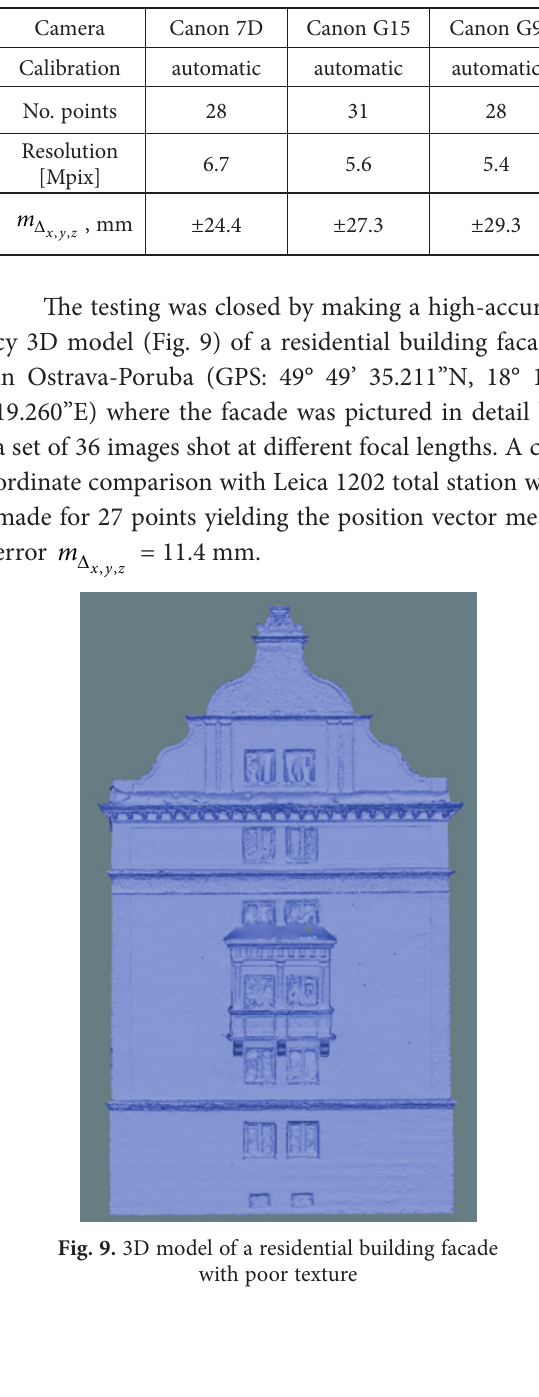
Table 6. Comparison differences for 3D models generated